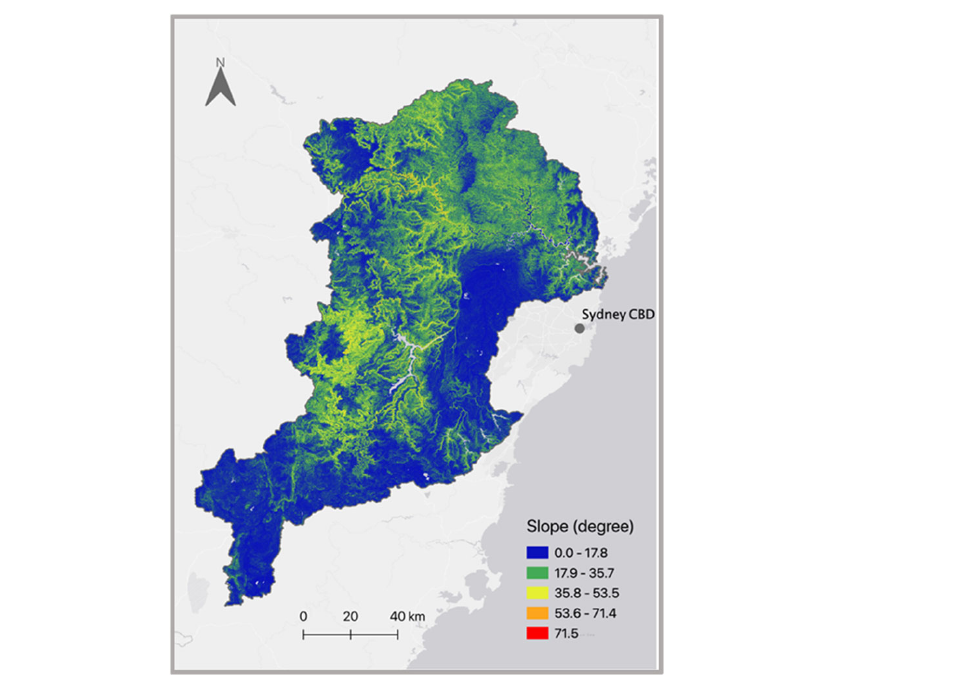
Figure 5. Map depicting degree of slope across the Hawkesbury-Nepean Catchment before standardising with Fuzzy membership.